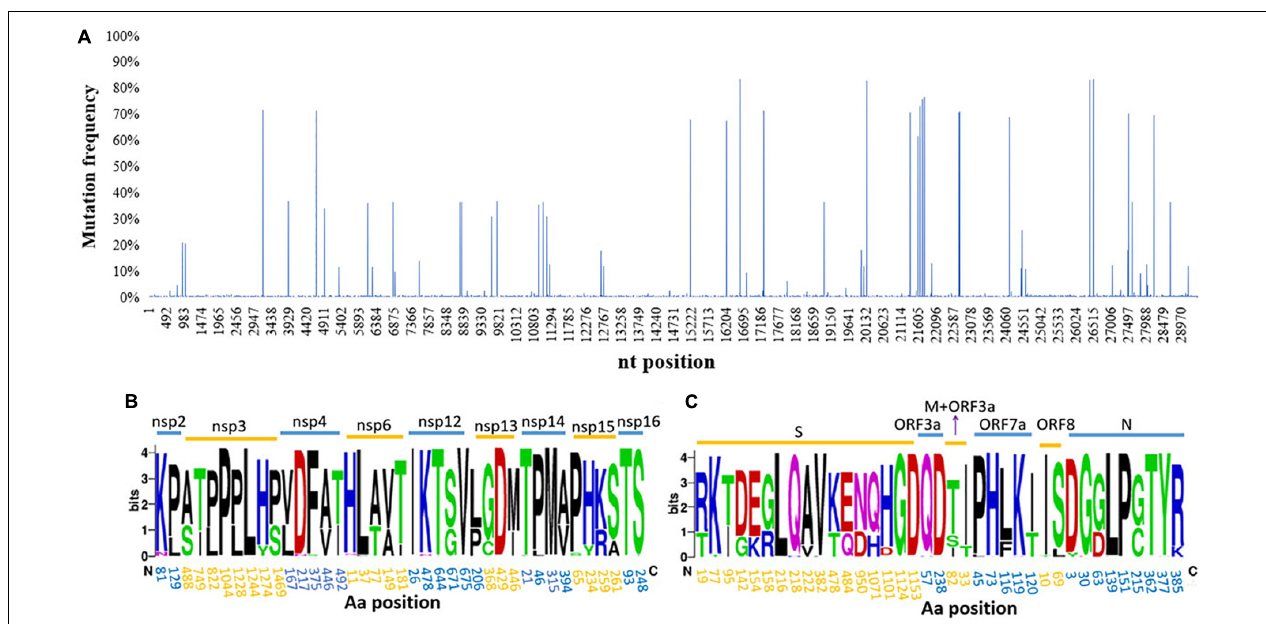
FIGURE 2 | Genetic diversity and amino acid (aa) substitutions affecting SARS-CoV-2 B.1.617. (A) The distribution of SNPs; a large number of SNPs were found widely distributed throughout the viral genomes sampled. Informative aa sequences detected in (B) non-structural proteins and (C) structural proteins. Informative sites were defined as locations where > 1% of the sequences had a different aa at that position. The names of different proteins are indicated above the line and aa positions within each protein below the line. SARS-CoV-2, severe acute respiratory syndrome coronavirus 2; SNP, single-nucleotide